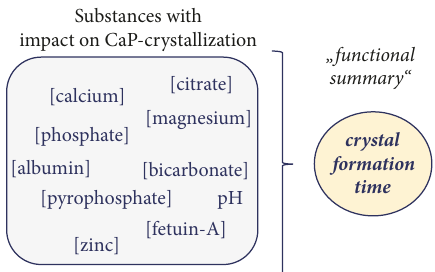
Figure 2: Crystal formation time is a measure of calcium phosphate crystallization. Crystal formation time functionally measures the transformation from amorphous primary (CPP1) to crystalline secondary (CPP2) calciprotein particles. It provides an integrated “functional summary” of crystallization promoting and inhibiting substances in serum and thus gives an estimate of the likelihood of